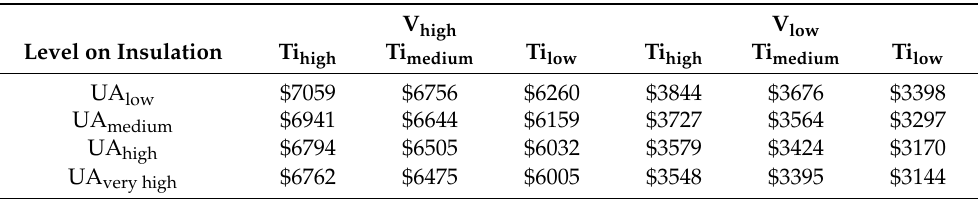
Table 13. Economic analysis (values reported in USD) for a general agricultural building for a heating season with a heat production of 1.6 W m − 2 . V high V low Level on Insulation Ti high Ti medium Ti low Ti high Ti medium Ti low UA low $7059 $6756 $6260 UA medium